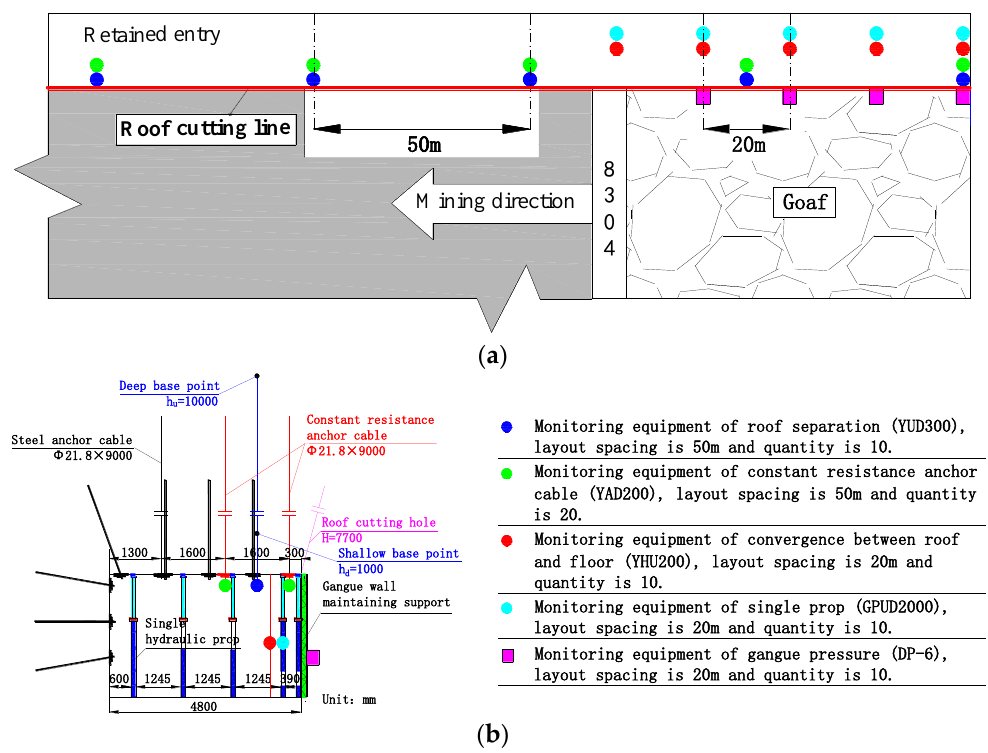
Figure 9 . Mine pressure monitoring scheme using GERRC: ( a ) Plan view layout; ( b ) Cross section layout.